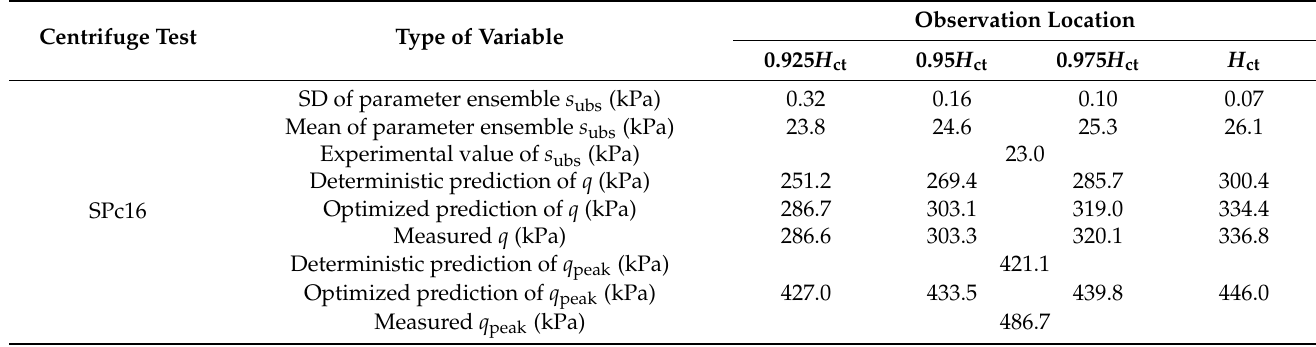
Table 4. Variations of data during the process of parameter optimization for Test SPc16.